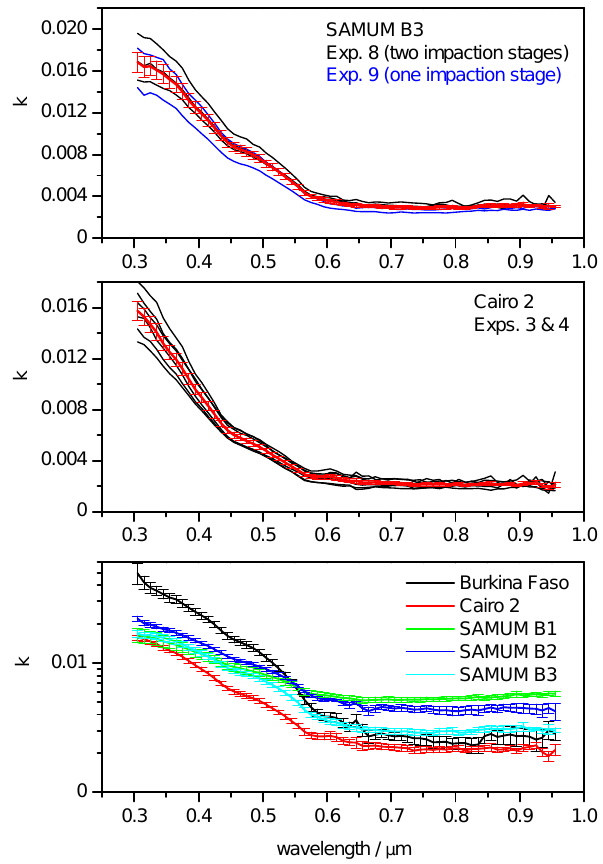
Fig. 10. Top panel: retrieved spectra of the imaginary part of the complex refractive index, k , for the SAMUM B3 dust sample from individual SOAP absorption measurements during Exp. 8 (black lines) and Exp. 9 (blue lines). The resulting mean k spectrum and its standard error, denoting the variability between the individual mea- surement cycles, are shown in red. Middle panel: retrieved k spectra for the Cairo 2 dust sample from six individual measurements with SOAP during Exps. 3 and 4 (black lines). As in the top panel, the mean k spectrum and its standard error are shown in red. Bottom panel: Mean k spectra and their standard error for all five investi- gated dust samples on a logarithmic k scale (SOAP retrievals).